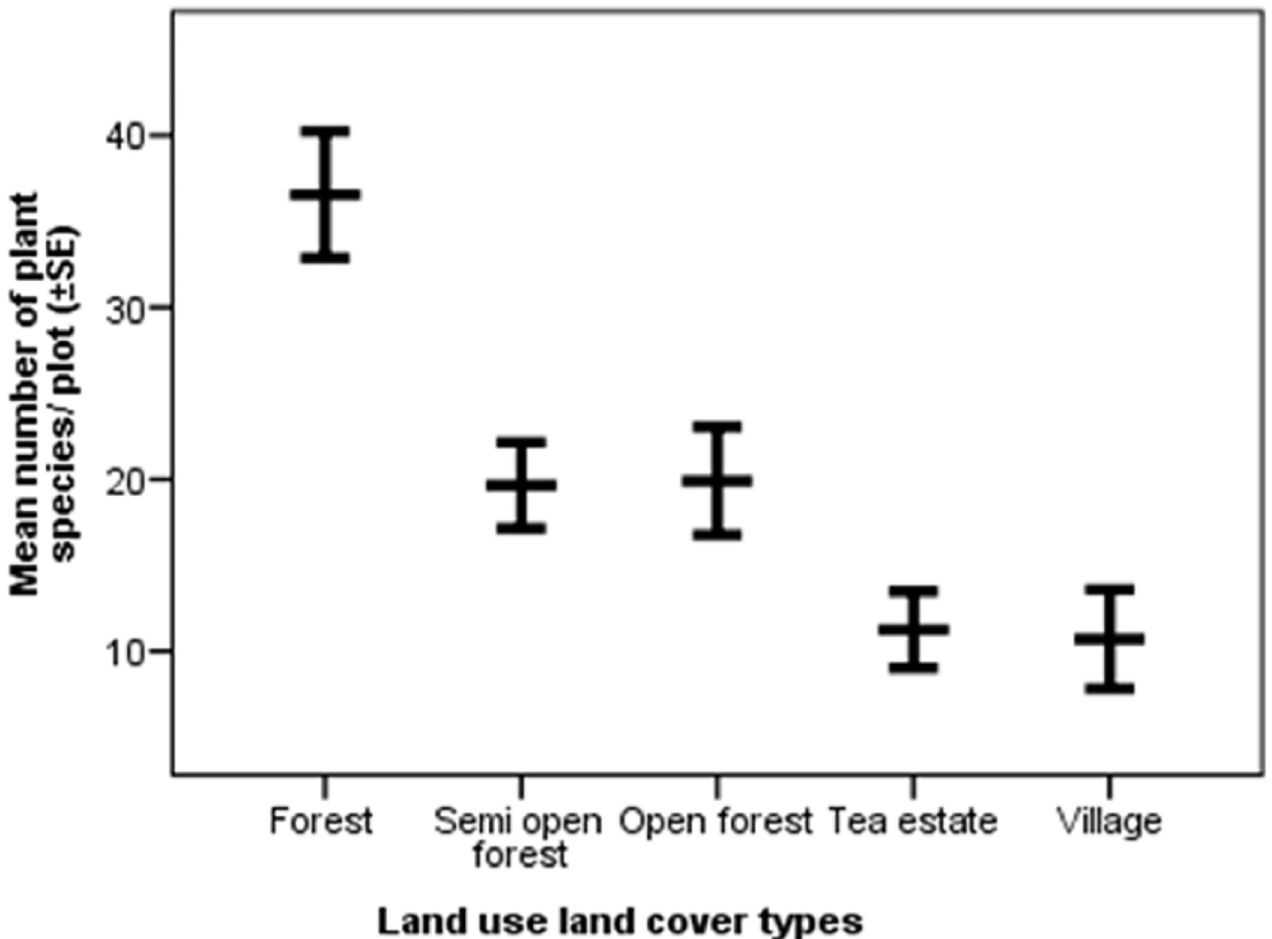
Fig 6. Mean ( ± SE) number of plant species/ plot recorded in different